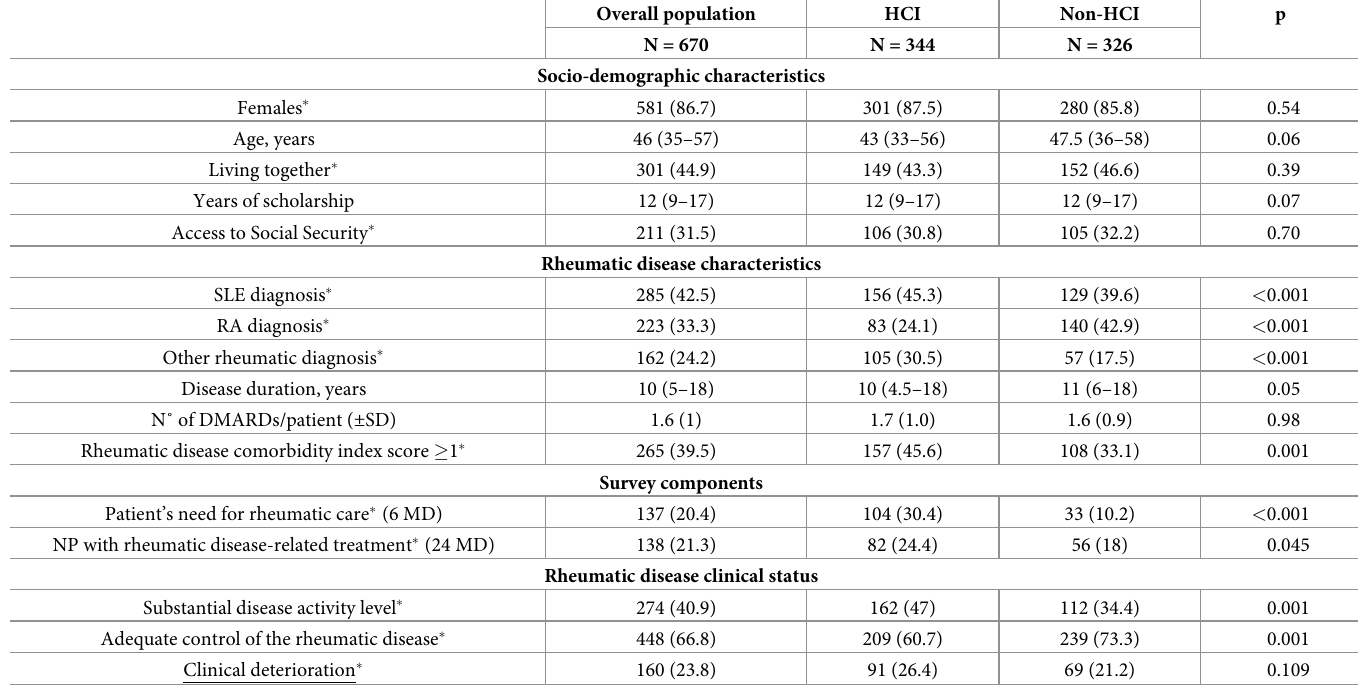
Table 3. Characteristics of the population and their comparison in the subpopulations defined according to HCI/non-HCI.